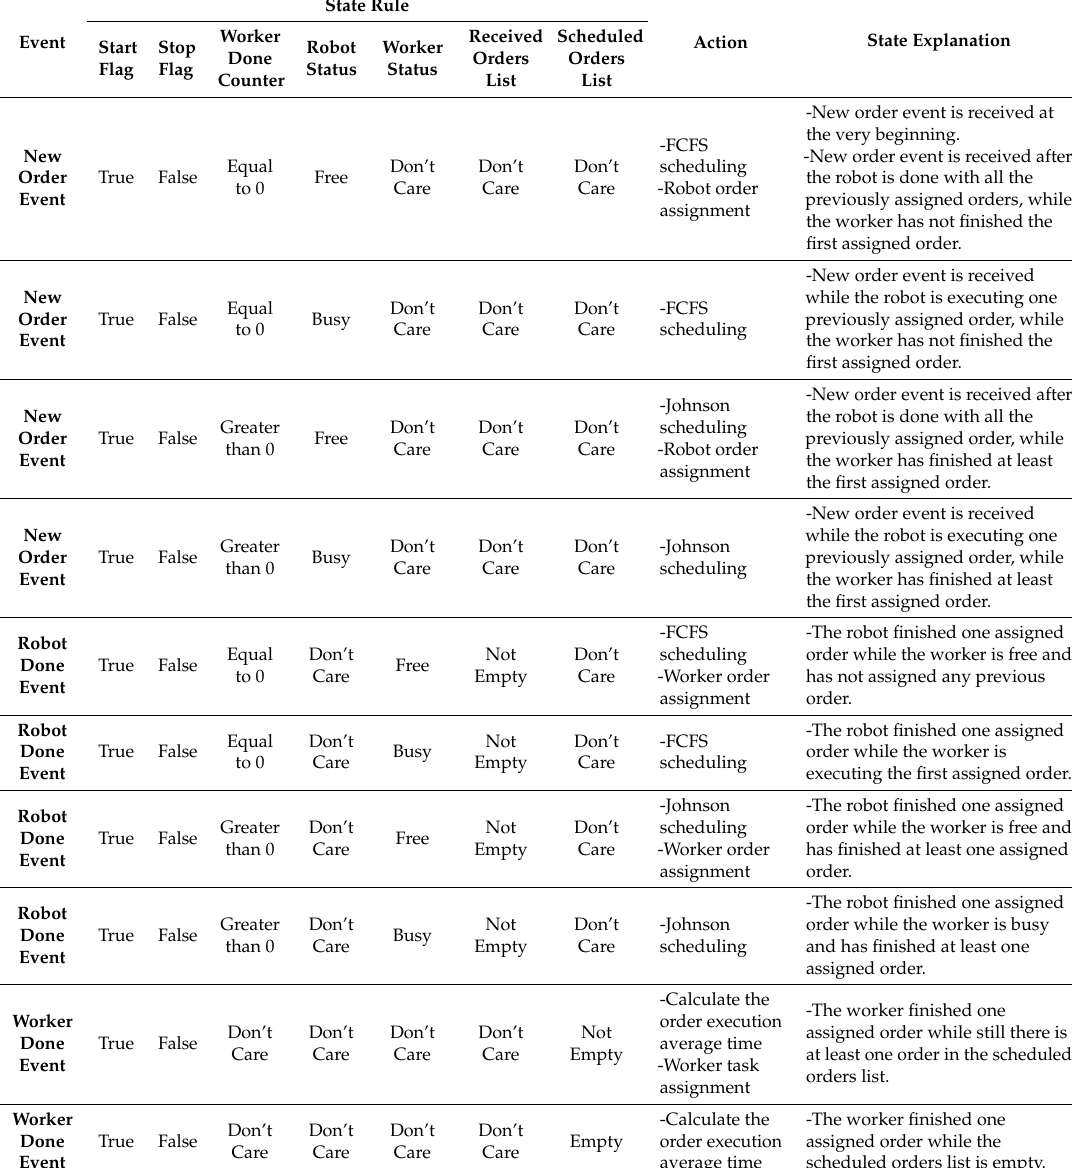
Table 3. Drools Scheduling and Order Assignment Decision